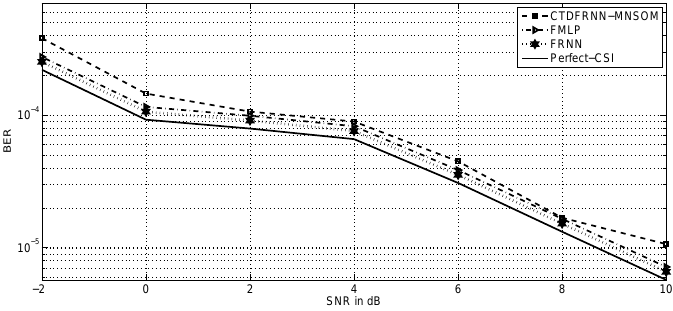
Figure 6. BER generated by FMLP and FTDFRNN in comparison to an estimator with perfect